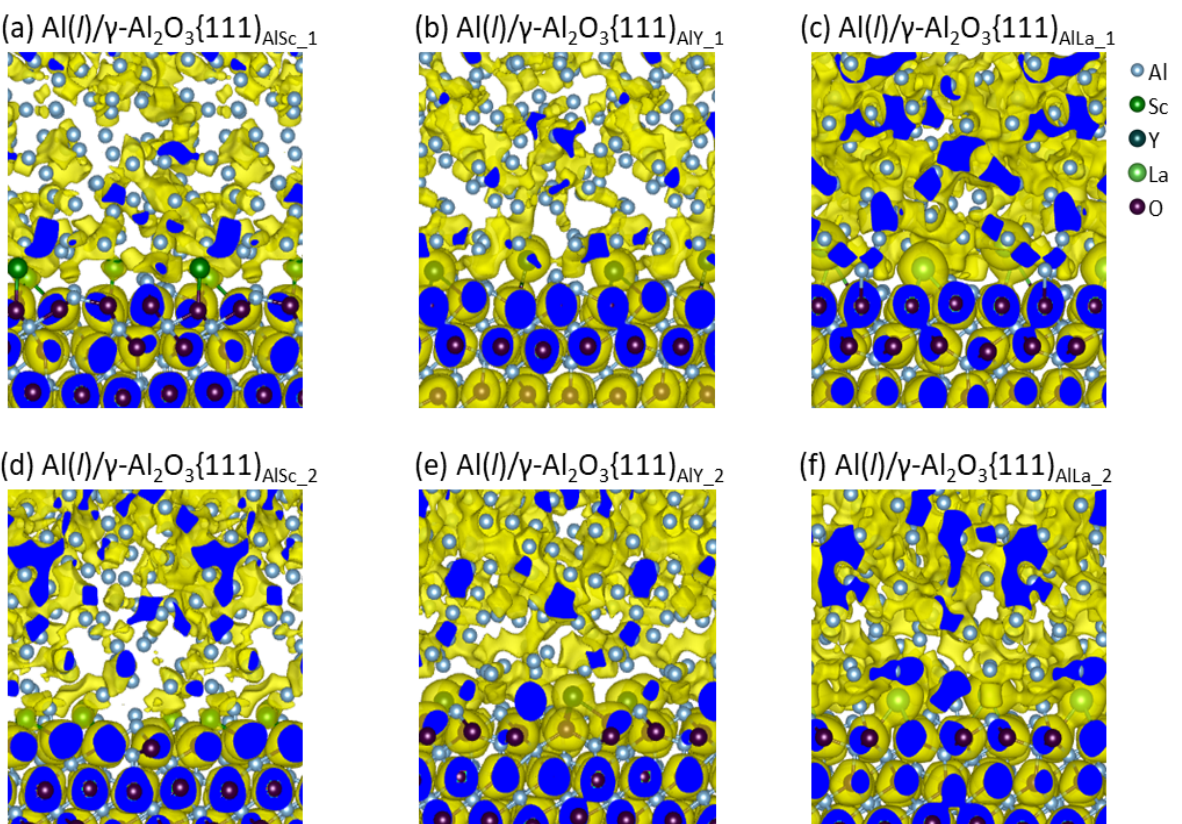
Figure 6. Iso-surfaces of electron density distributions ( ρ 0 ( r ) = 0.035e/Å 3 ) at the Al( l )/ γ -Al 2 O 3 {1 1 1} AlM interfaces at 6 ps. The yellow clouds represent the iso-surfaces (the electron density, ρ 0 ( r )). The blue regions represent higher density whereas the white lower density. These Figures show clearly the ionic nature of O and metallic nature of Al, as well as the chemical bonding between the Group 3 atoms and the outmost O. ( a ) Al( l )/ γ -Al 2 O 3 {111} AlSc_1 , ( b ) Al( l )/ γ -Al 2 O 3 {111} AlY_1 , ( c ) Al( l )/ γ -Al 2 O 3 {111} AlLa_1 , ( d ) Al( l )/ γ -Al 2 O 3 {111} AlSc_2 , ( e ) Al( l )/ γ -Al 2 O 3 {111} AlY_2 , ( f ) Al( l )/ γ -Al 2 O 3 {111} AlLa_2 . The O atoms in the substrates have high electronic densities with spherical shapes, which corresponds to their ionic nature due to the high electronegativity value. All the Al atoms in the substrates, in the liquid and at the interfaces exhibit low electron densities (Figure 6). This relates to its low electron affinity and metallic nature. There is a low electron density around the Sc atoms, indicating their metallic/ionic nature. The high electron densities around the Y and La atoms originate from the semi-core electrons. There are clear overlaps between the electron density clouds around the Y/La and the O. This related to the chemical